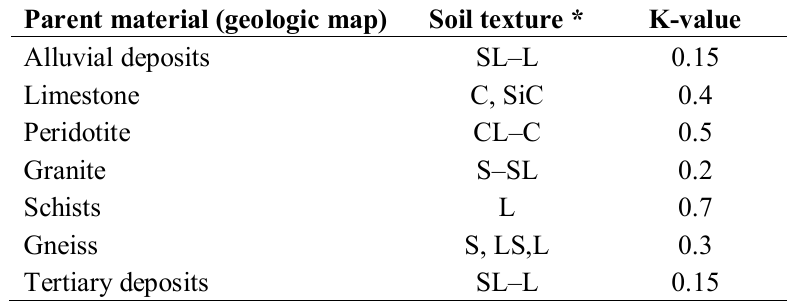
Table 1. K-values inferred from the geological formations with